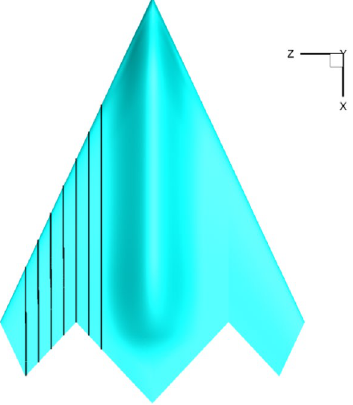
Figure 12. Schematic diagram of span-wise section